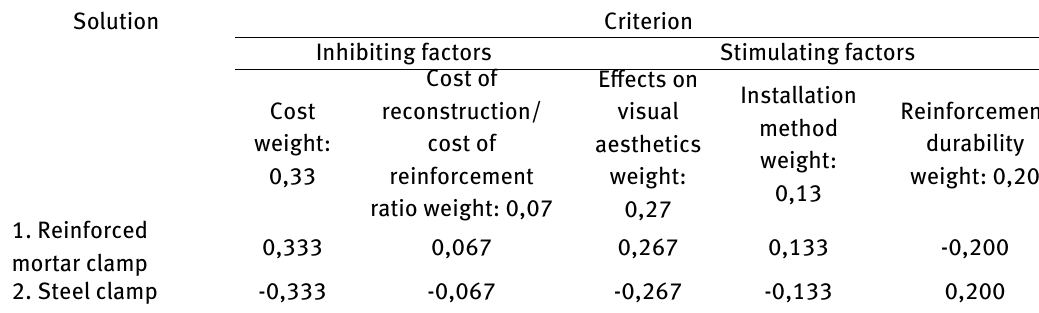
Table 10: Results of the standarization method calculations (own studies)